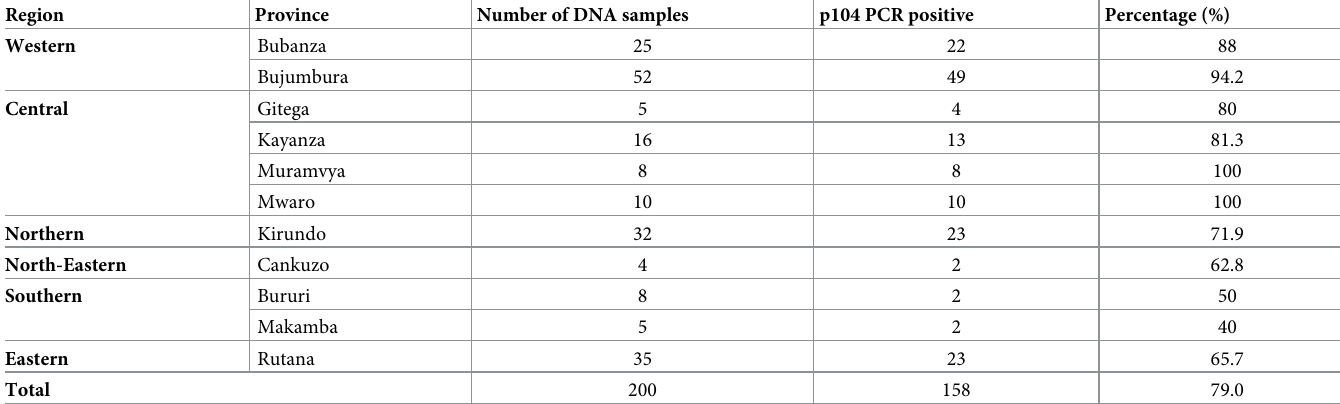
Table 3. Proportion of Theileria parva p104 PCR positive samples collected from different provinces in Burundi. Region